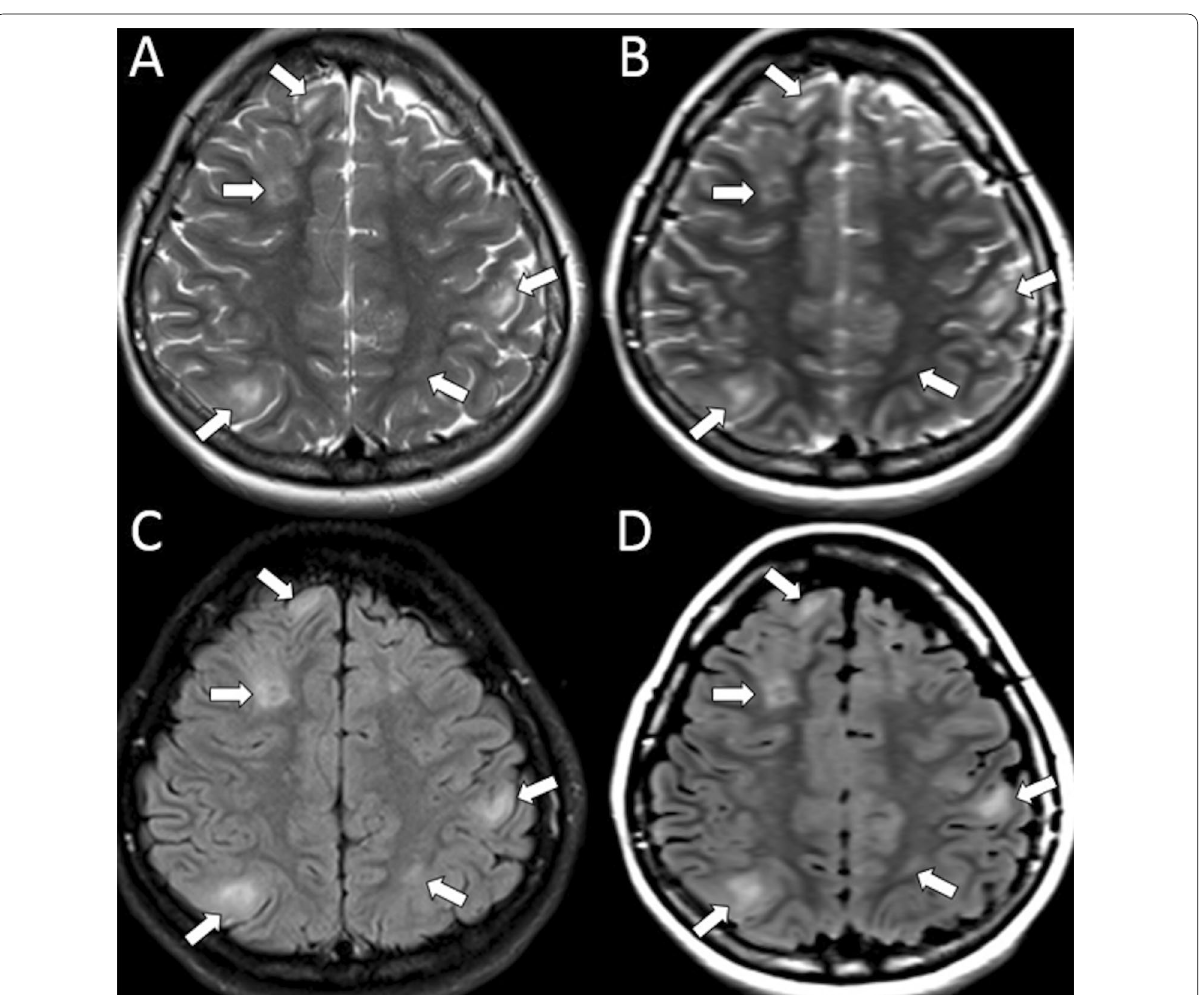
Fig. 1 Synthetic (Sy) T2-weighted ( B ) and Sy-FLAIR ( D ) images show cortical/subcortical tubers accurately as on the conventional T2W ( A ) and FLAIR ( C )